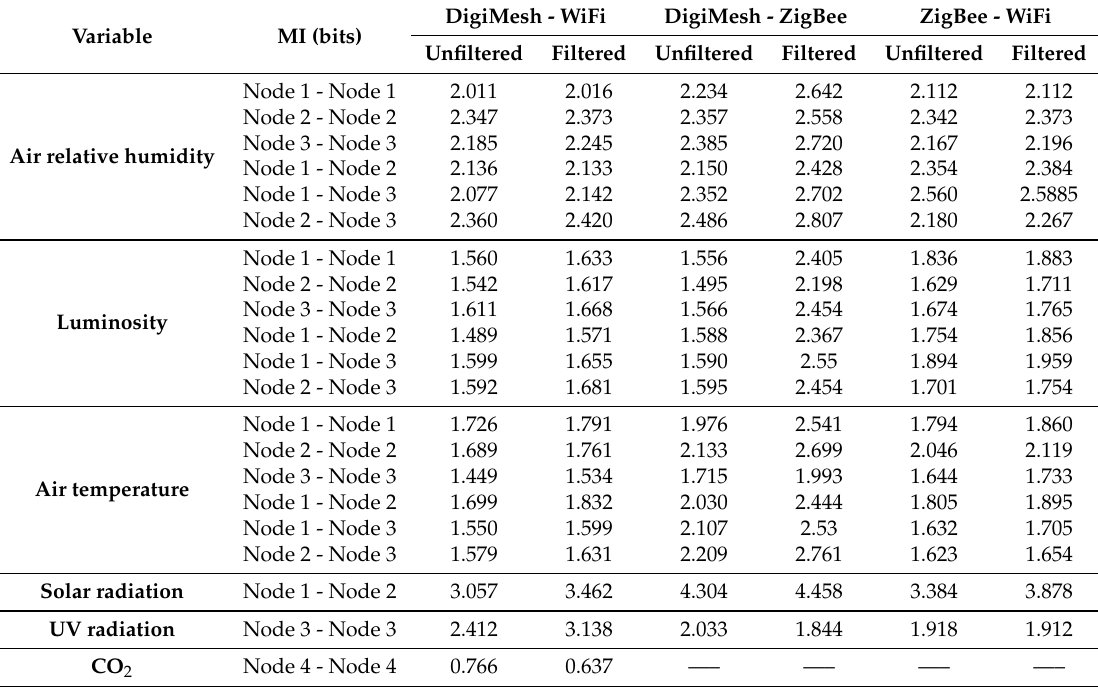
Table 4. MI results compared between two sensor nodes of different